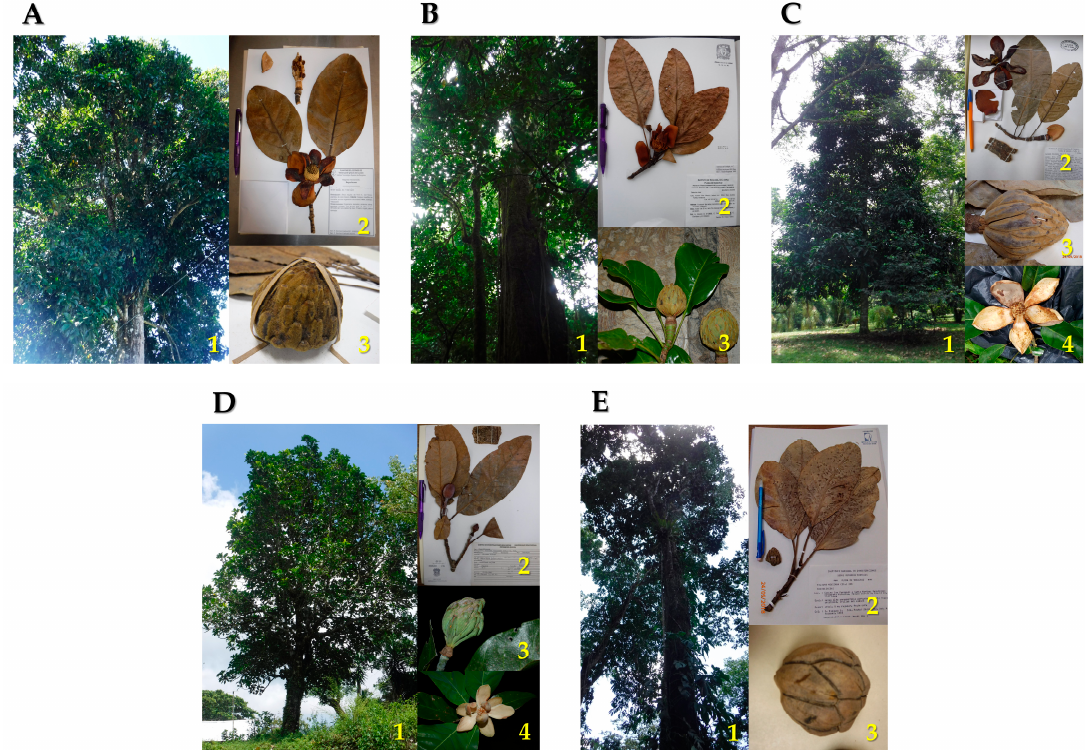
Figure 1. Morphology of Magnolia sect. Talauma in Puebla and Veracruz, Mexico. ( A ) Magnolia decastroi : 1. Tree, 2. Voucher, 3. Fruit; 1–3 By F.A. Aldaba N ú ñez, 2019. ( B ) Magnolia lopezobradorii : 1. Tree, 2. Voucher, 3. Fruit; 1–2 By F.A. Aldaba N ú ñez, 2019, 3 By E.M. Mart í nez Salas, 2019. ( C ) Magnolia mexicana : 1. Tree, 2. Voucher, 3. Fruit, 4. Flower; 1–4 By F.A. Aldaba N ú ñez, 2019. ( D ) Magnolia sinacacolinii : 1. Tree, 2. Voucher, 3. Fruit, 4. Flower; 1–2 By F.A. Aldaba N ú ñez, 2019, 3–4 By E.M. Mart í nez Salas, 2019. ( E ) Magnolia zoquepopolucae : 1. Tree, 2. Voucher, 3. Fruit; 1–3 By F.A. Aldaba N ú ñez, 2019.